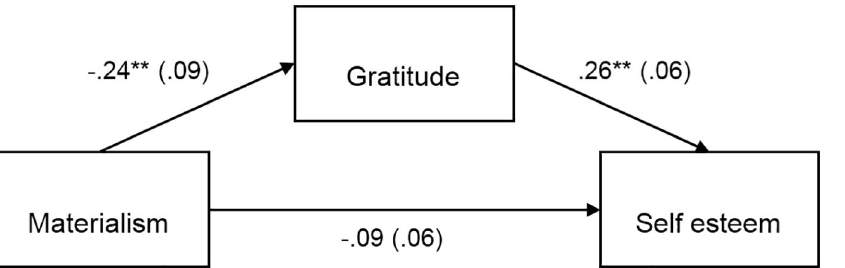
Figure 2. Materialism indirectly predicts self esteem through its relationship with gratitude, b = -.06, SE = .03, 95% CI [-.14, -.02]. Unstandardized coefficients shown with standard error in parentheses. ** p < .01.